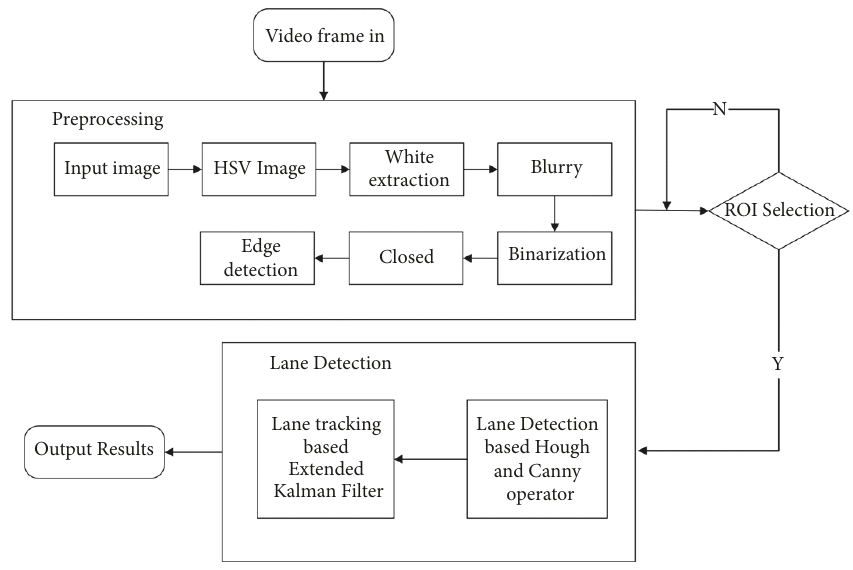
Figure 1: Block diagram of proposed